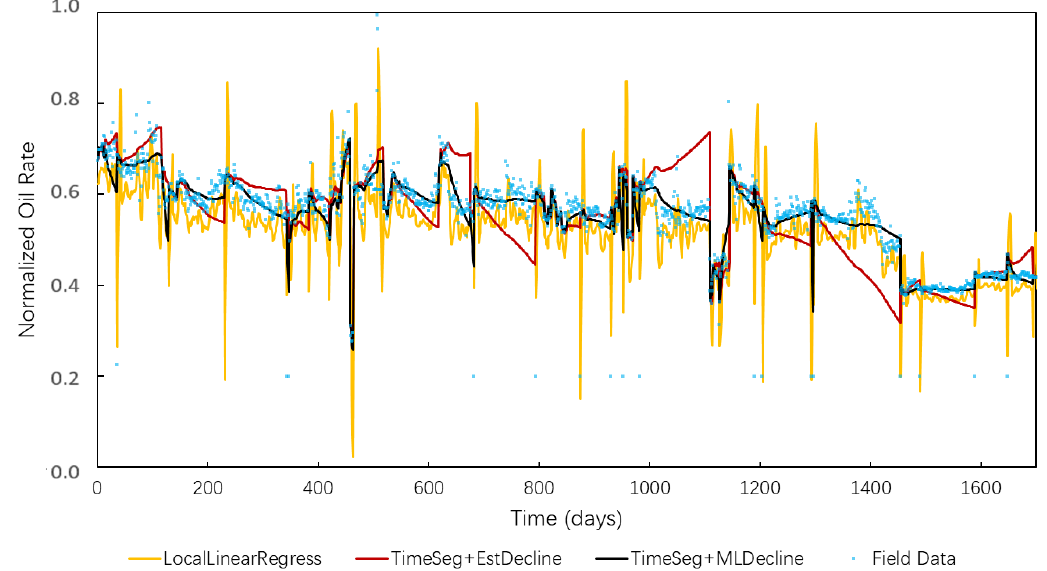
Figure 12. Comparison between the field recorded data and the machine learning predicted data for the whole life of one producer.